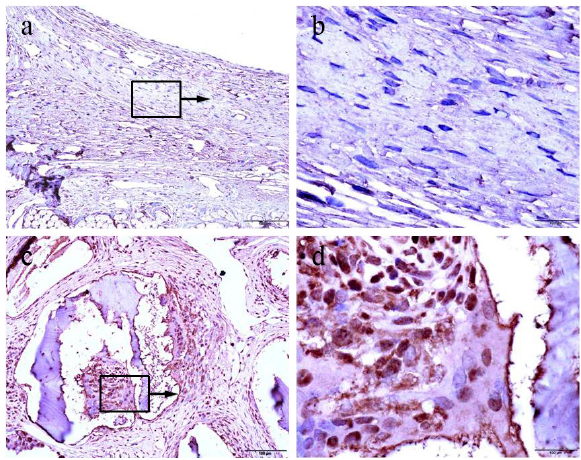
Figure 4. Expression patterns of proliferating cell nuclear antigen (PCNA) in tissue sections detected by immunohistochemistry: example of a negative ( a , b ) and positive ( c , d ) patterns of PCNA expression in tissue sections. The boxed areas in the left panels (200 × magnification) are magnified in the corresponding panels on the right (1000 × magnification).